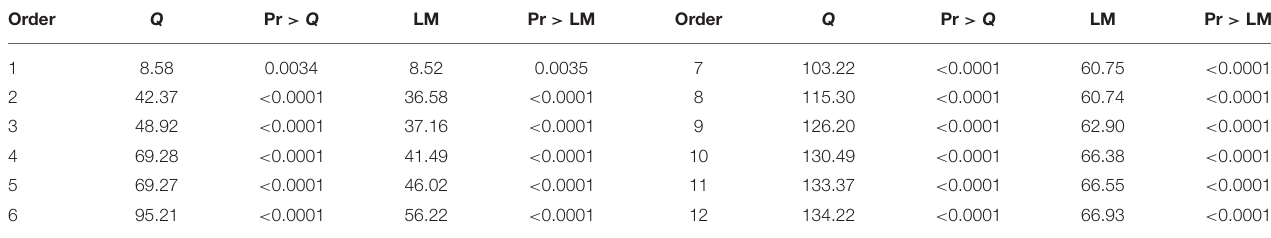
TABLE 8 | Model (7) ARCH test of residuals.